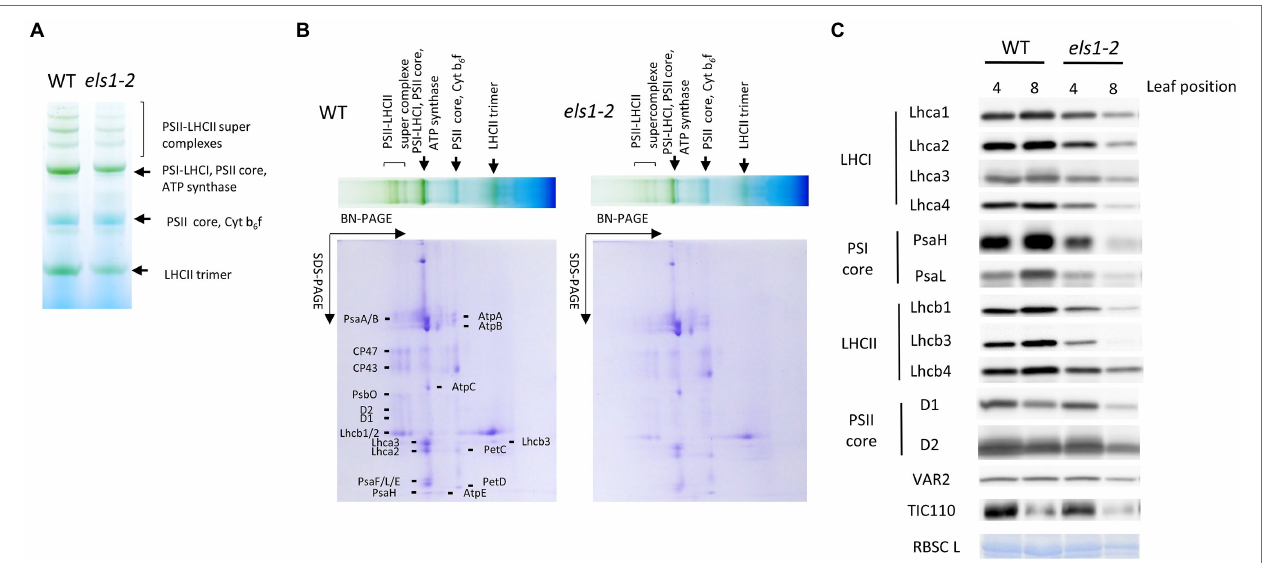
FIGURE 4 | Thylakoid protein accumulation in els1-2 . To examine the thylakoid membrane proteins and pigment complexes from pre-senescent leaves (the upper 4th leaves) of WT and els1-2 , we performed (A) blue native PAGE analysis and (B) two-dimensional electrophoresis. SDS-PAGE was visualized by CBB staining. (C) Western blot of chloroplast proteins from pre-senescent (the upper 4th leaves) and senescent (the upper 8th leaves) leaves of WT and els1-2 . Lhca1-4 are LHCI apoproteins; PsaH and L are photosystem I reaction center subunits; Lhcb1, 3, and 4 are LHCII apoproteins; D1 and D2 are photosystem II reaction center subunits; VAR2, TIC110, and RBSC L represent thylakoid membrane-localized protein, envelope-localized translocon protein, and stroma-localized protein, respectively. RBSC L was visualized by CBB